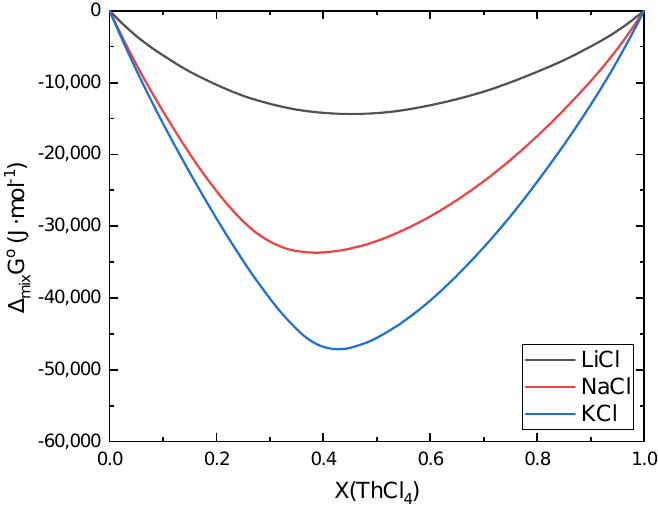
Figure 5. Gibbs energies of mixing of the (A,Th)Cl x liquid solutions calculated at T = 1100